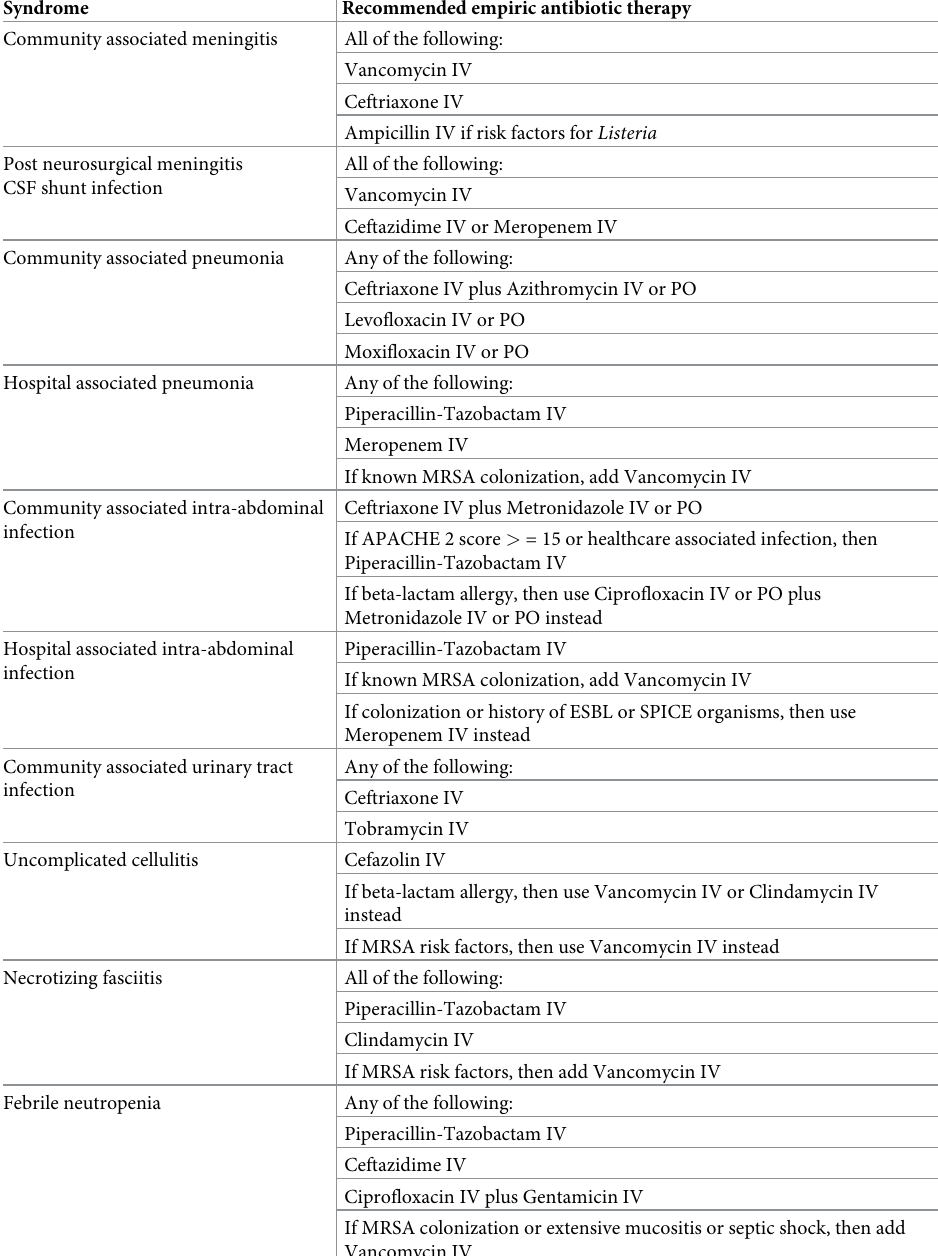
Table 1. Hospital guidelines on empiric antibiotic